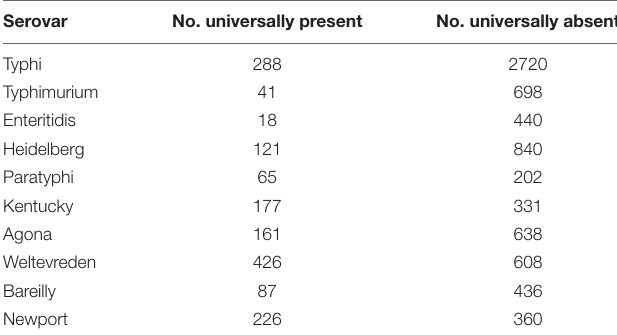
TABLE 6 | The number of pan-genome regions that were universally present and absent, as well as statistically over- or under-represented in comparison to all other genomes, within the 10 most abundant serovars within the 4870 subspecies enterica genomes of this study.